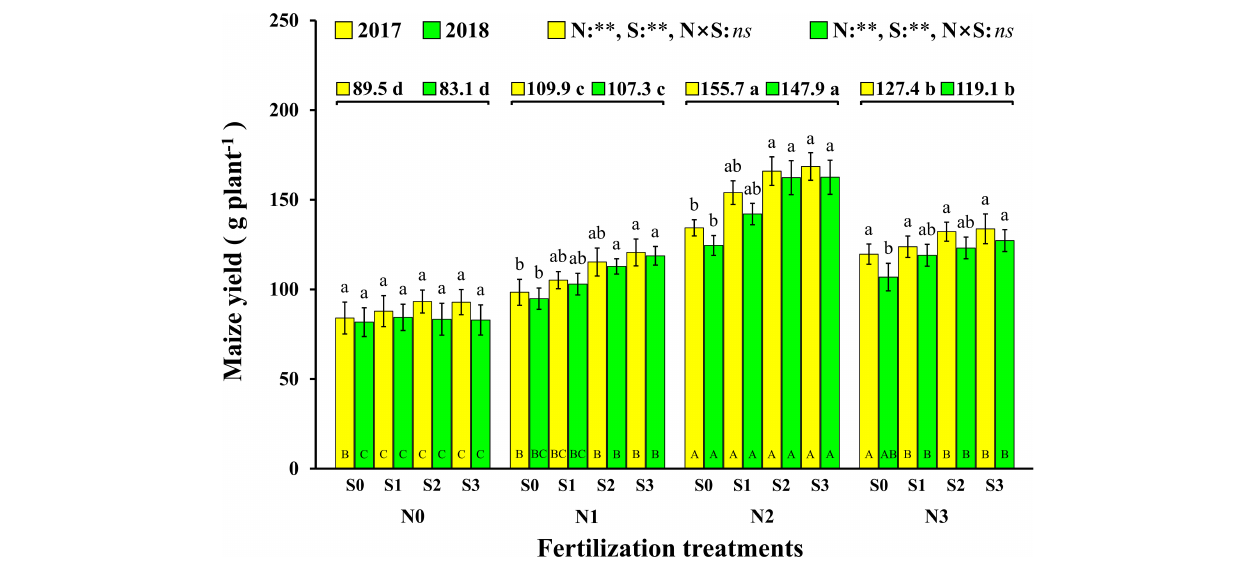
FIGURE 2 | Effect of N and S on maize yield. The data are the means of four replicates, and the error bars represent the standard deviations. The lowercase letters above the bars indicate the significant differences between the different S rates at the same N level in the same year, and the different uppercase letters in the bars indicate the significant differences between the different N rates at the same S level in the same year. The number on the horizontal line above each group of bars indicates the average value of grain yield of maize at different N levels in the same year, and the lowercase letters after the numbers indicate the significant difference in yield at different N levels. The variance analysis used two-way ANOVA ( ∗∗ P < 0.01, ns P > 0.05).